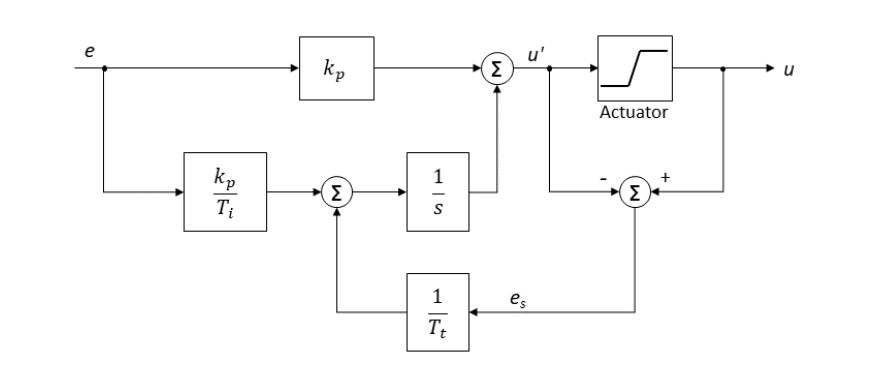
Figure 4. Block diagram of a PI (Proportional-Integral) controller with an anti-windup mechanism.